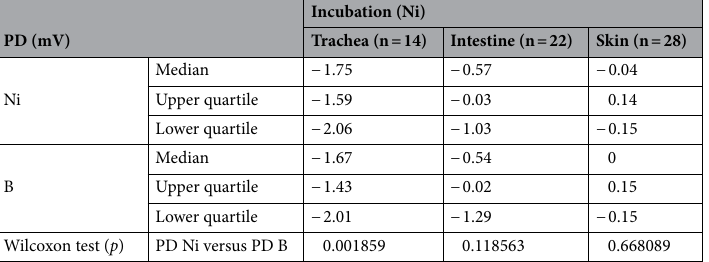
Table 5. Transepithelial electric potential (PD) of the trachea, intestine and skin specimens measured in stationary conditions at the beginning of experiments and treated with nickel chloride (0.1 mM) and bumetanide (0.1 mM). The values of medians and lower and upper quartiles are given. Abbreviations: B—bumetanide (0.1 mM) solution, Ni—nickel chloride (0.1 mM) and bumetanide (0.1 mM) solution, PD—transepithelial potential difference of the tissue surface (mV) measured in stationary conditions at the beginning of experiments, p < 0.05.